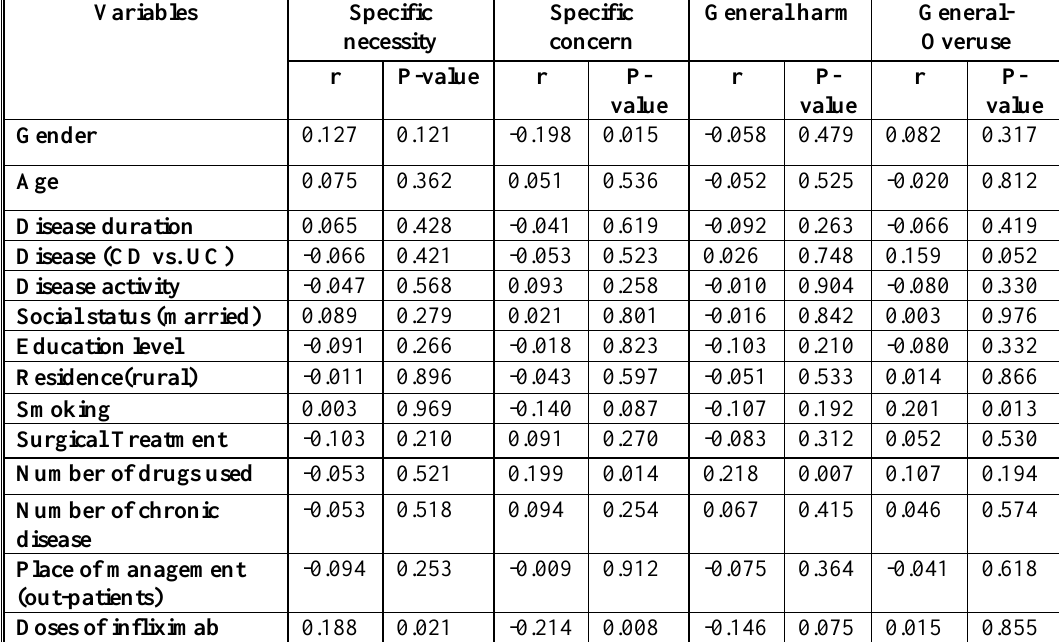
Table 6. Linear regression analysis between BMQ components and other variables for all